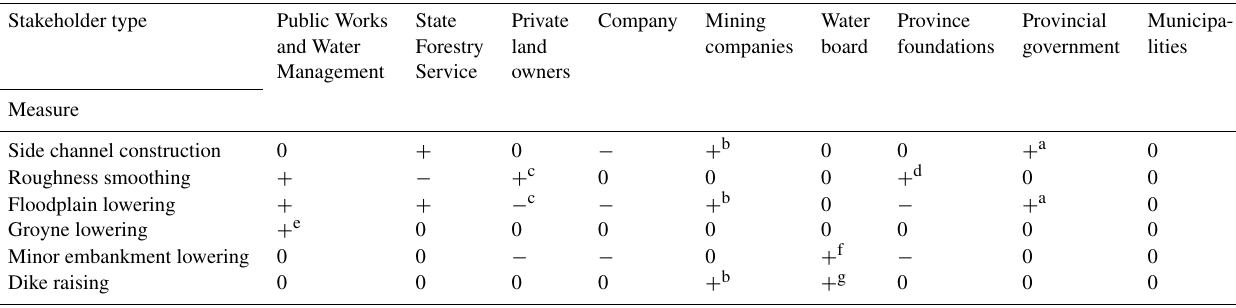
Table 4. Simplified stakeholder preferences for different